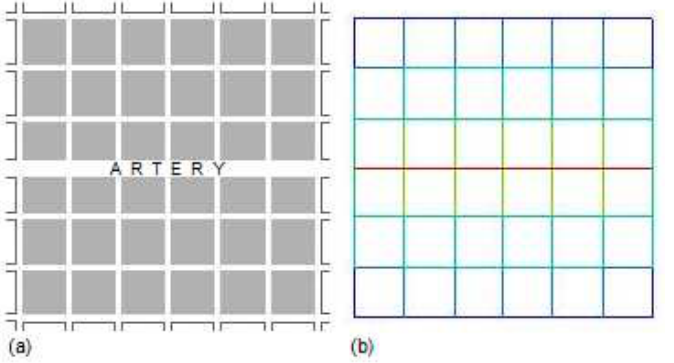
Figure 8. Type 1 unit-segment analysis. (a) Hypothetical roadway structure; land-use blocks are shown in solid shades. The central wider roadway unit is an artery, and all others are residential streets. (b) Unit-segment- integration map; integration reduces as the color of the lines changes from red to